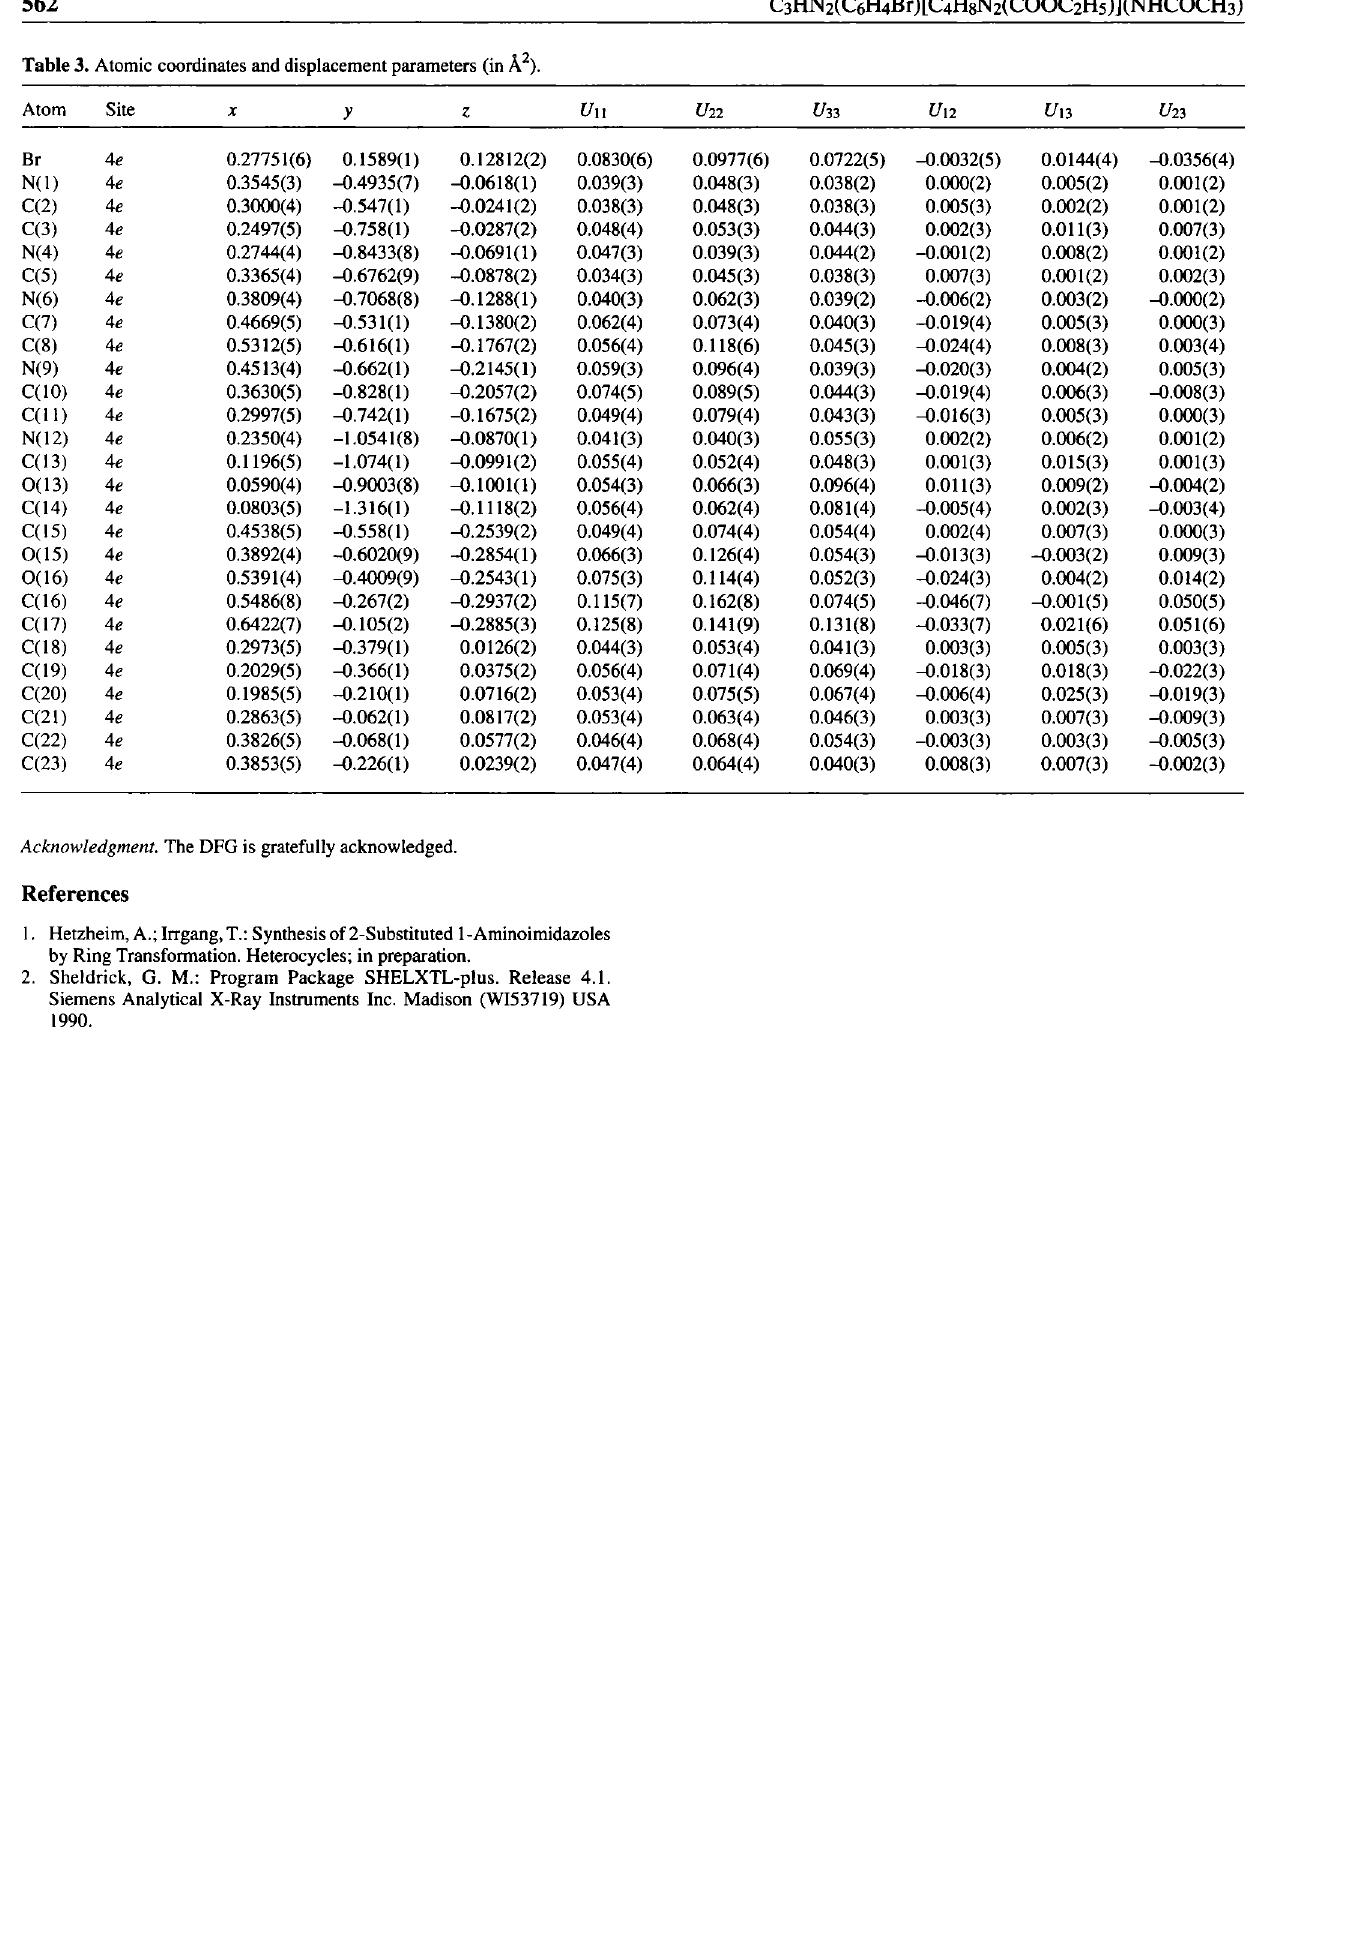
Table 3. Atomic coordinates and displacement parameters (in Ä 2